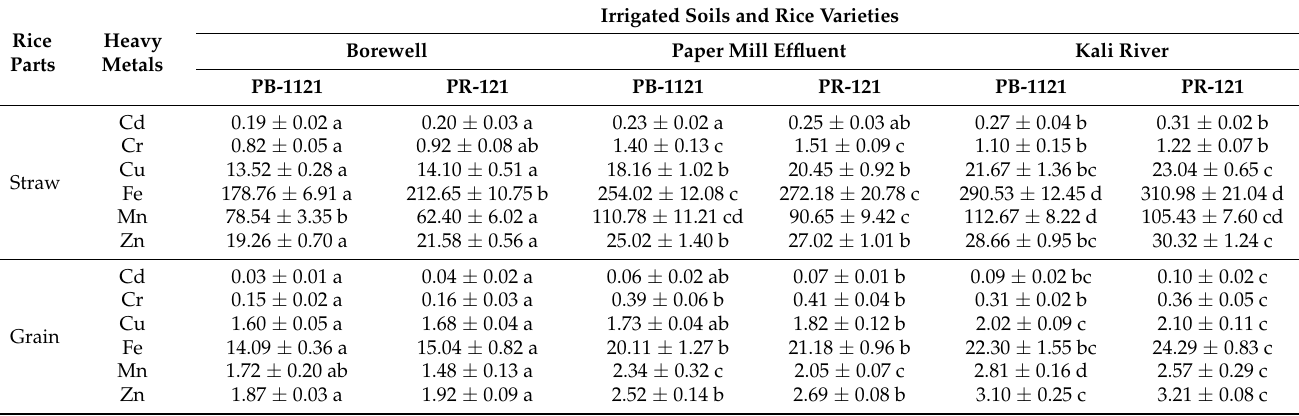
Table 4. Impact of different irrigation water sources on heavy metal accumulation (mg/kg) in grains of two rice varieties.